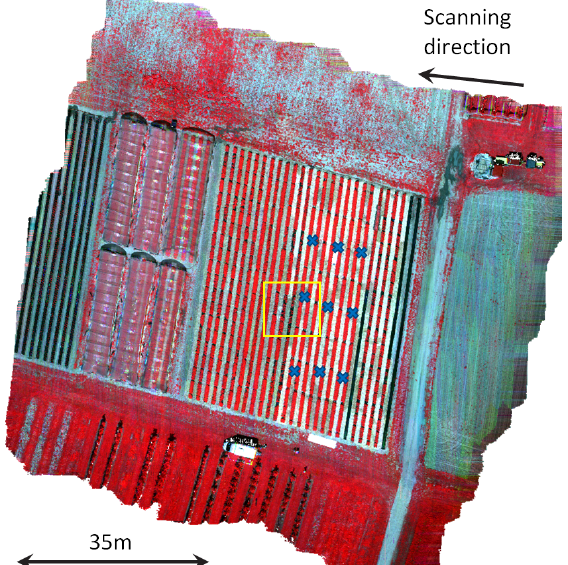
Figure 4. An overview of an experimental strawberry field near Sint Truiden, Belgium. Area marked in yellow is enlarged in Figure 5. Geometric reference targets